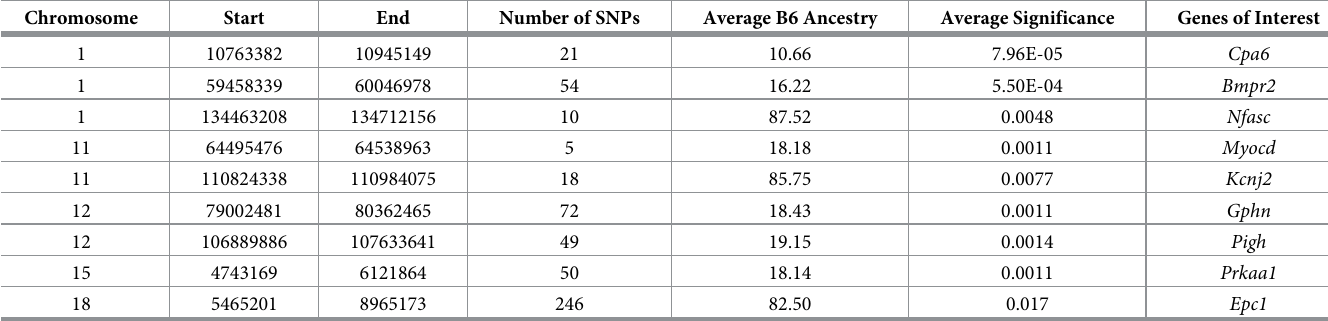
Table 2. Regions with significant and sustained B6 depletion or